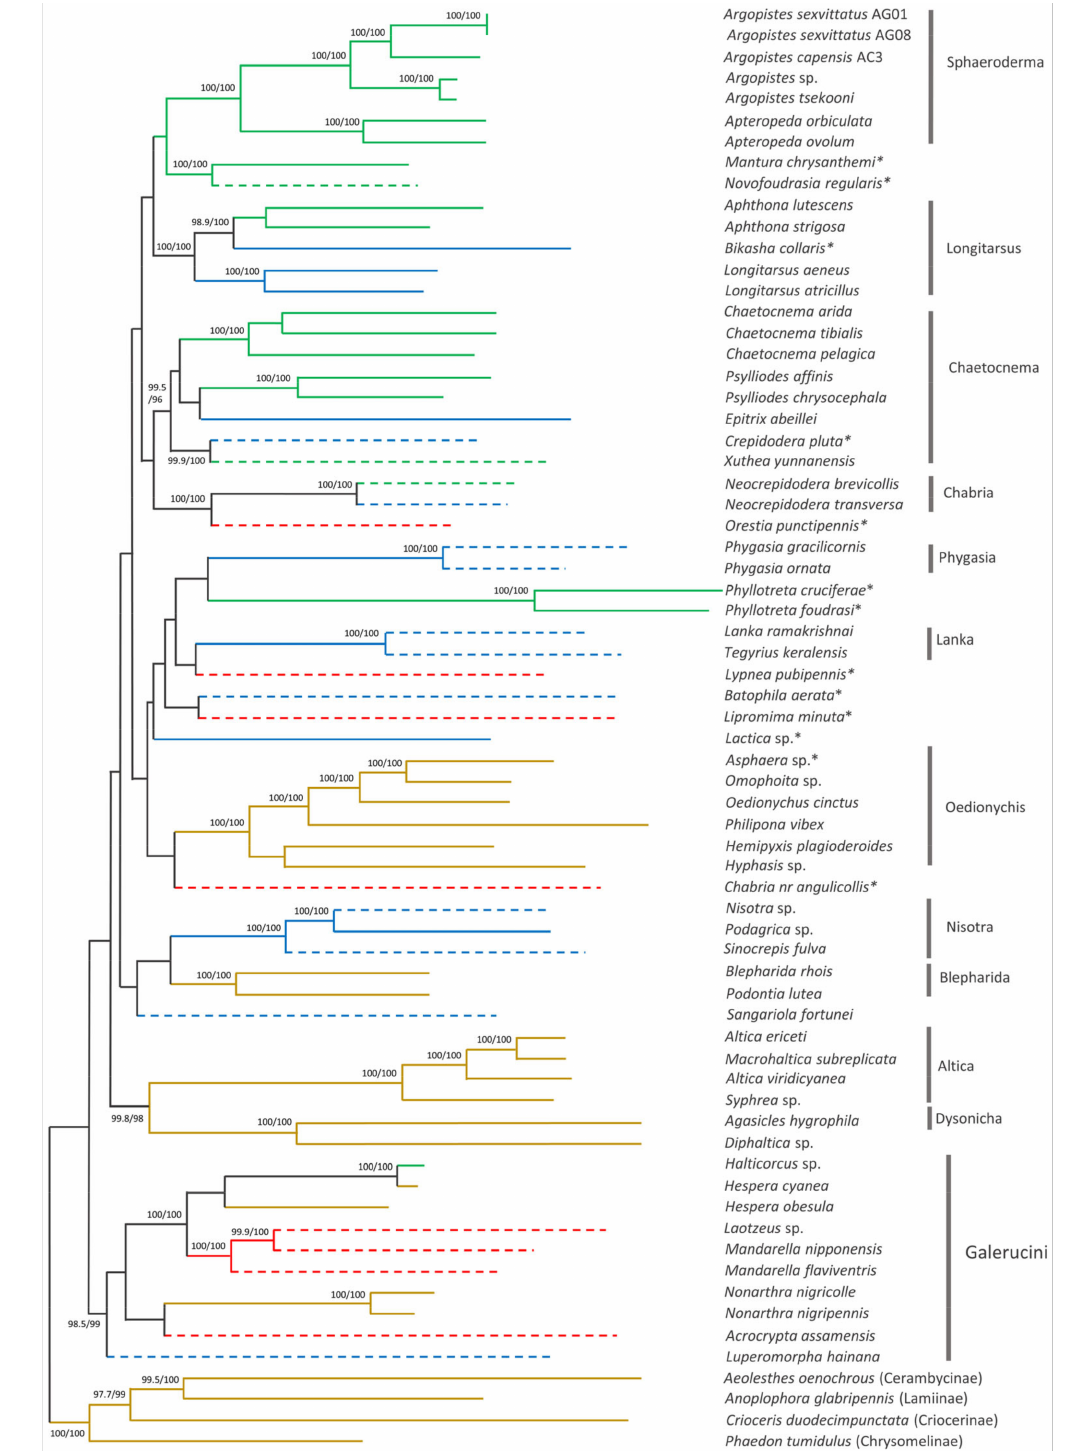
Figure 8. Maximum likelihood phylogenetic tree of 64 Alticini species based on 13 mitochon- drial protein-coding genes. Nodal support is given as SH-aLRT (%)/ultrafast bootstrap (%); only values >95% are shown. Branch colours represent larval feeding habits: leaf miner—green; ex- ternal leaf feeder—brown; root feeder—blue; unknown—red. Dashed branches represent possi- ble/unconfirmed/unclear larval feeding habits. * Genus group